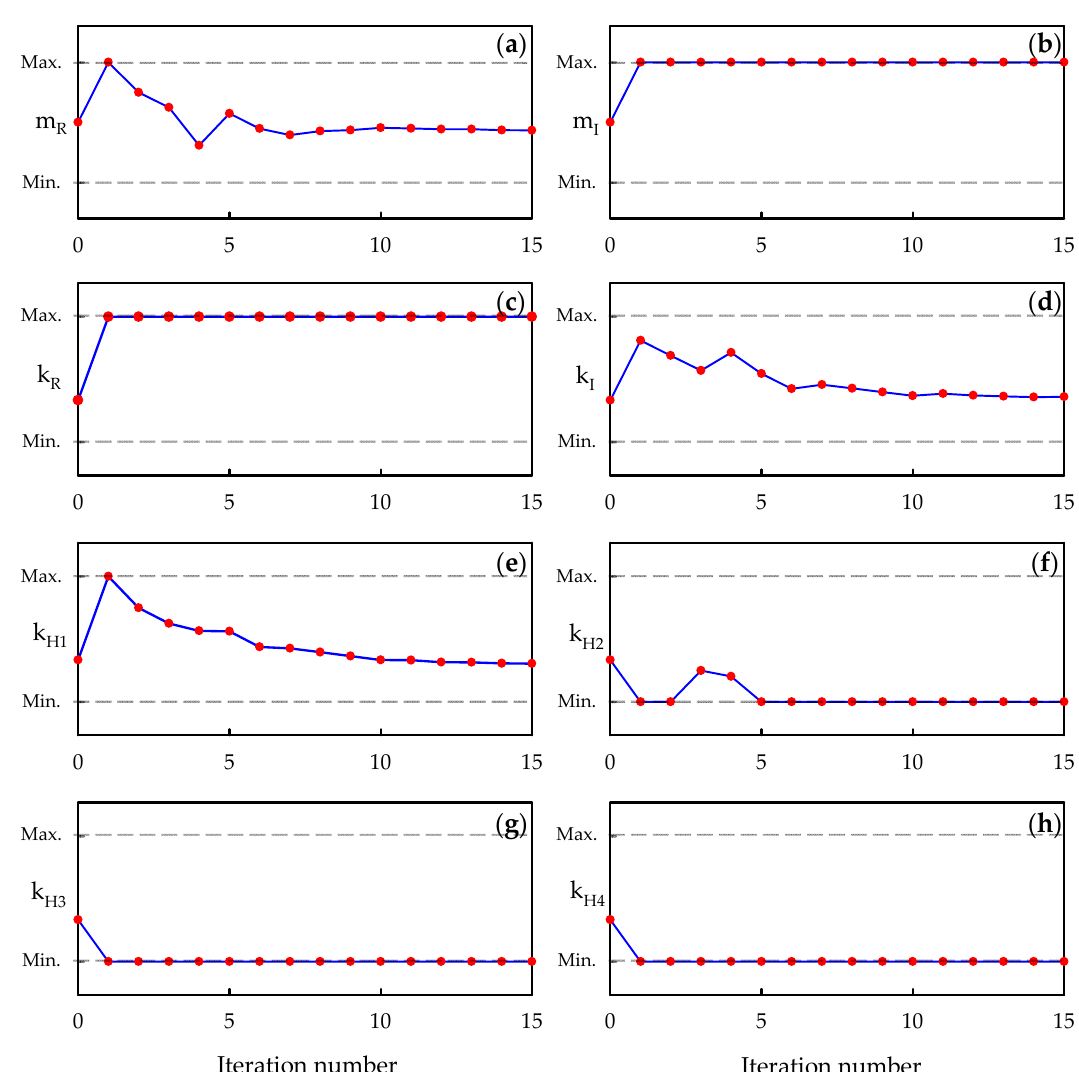
Figure 21. Convergence plots of the eight design variables in the design optimization: ( a ) radiator mass; ( b ) intercooler mass; ( c ) rubber bushing stiffness of the radiator; ( d ) rubber bushing stiffness of the intercooler; ( e ) upper hose stiffness of the radiator; ( f ) lower hose stiffness of the radiator; ( g ) upper hose stiffness of the intercooler; and ( h ) lower hose stiffness of the intercooler.